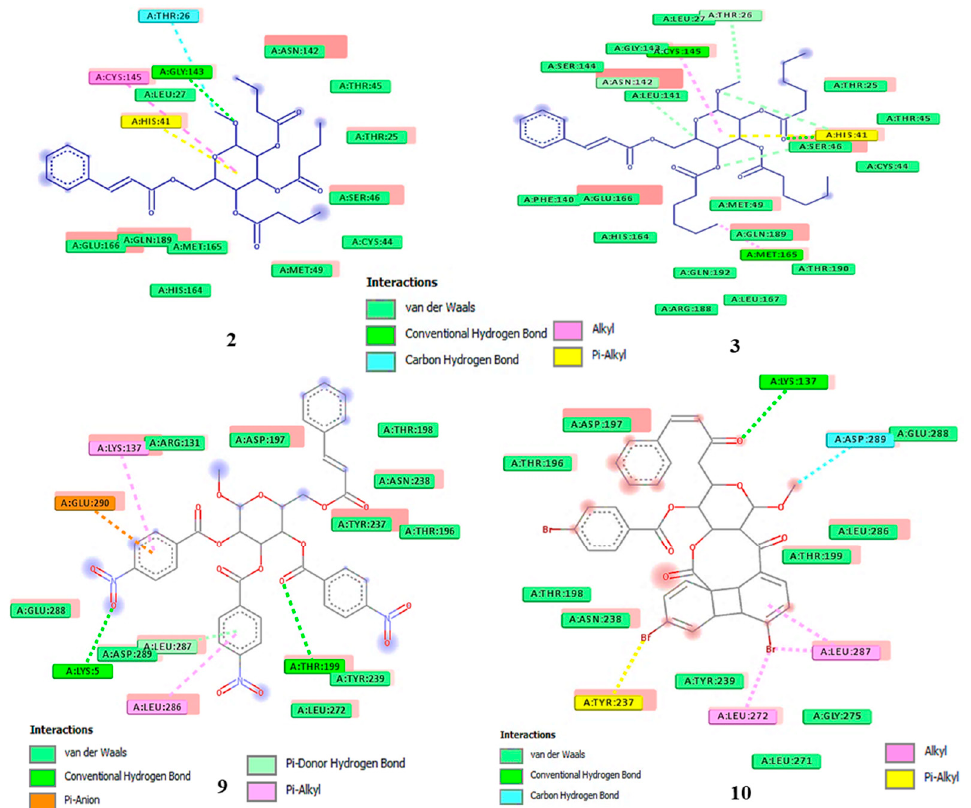
Figure 6. Non-bonding interactions of compound ( 3 , 4 , 9 , and 10 ) with the amino acid residues of 6Y84 generated by Discovery Studio.